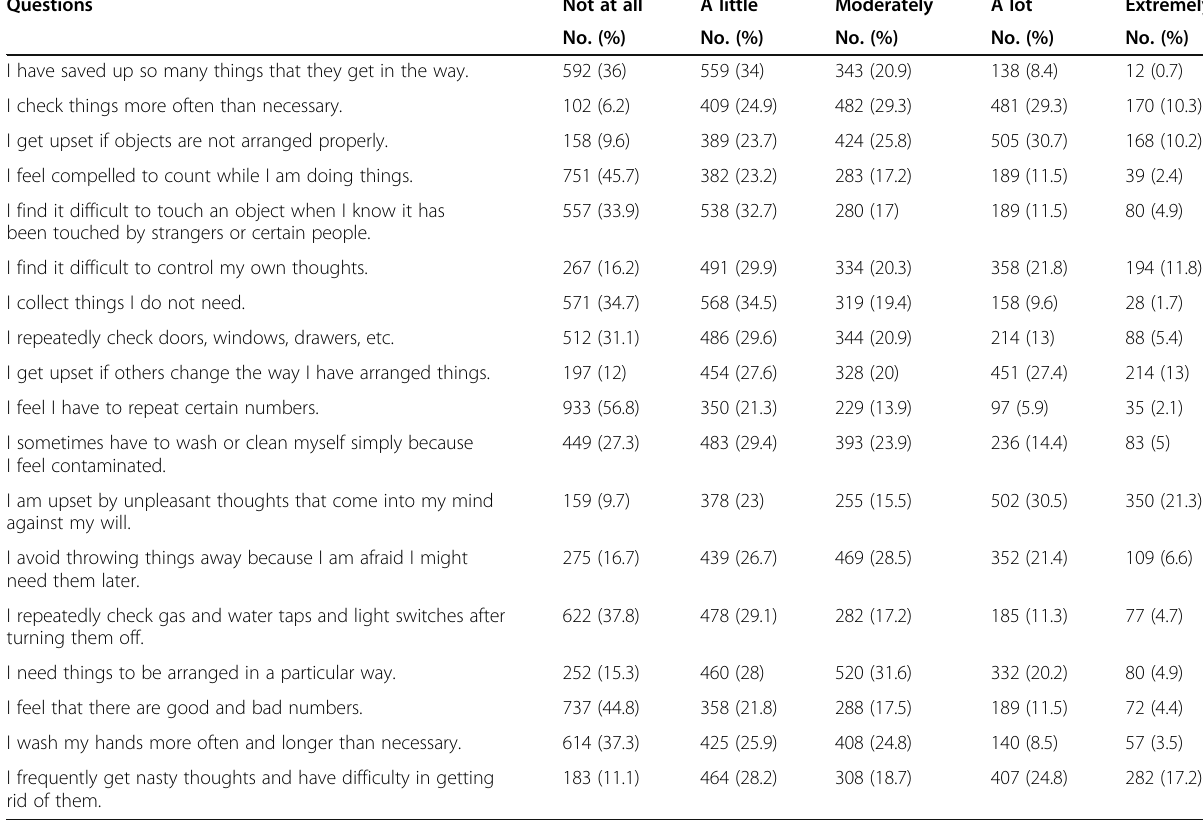
Table 3 Frequency distribution of the participant ’ s answers for OCI-R score items Questions Not at